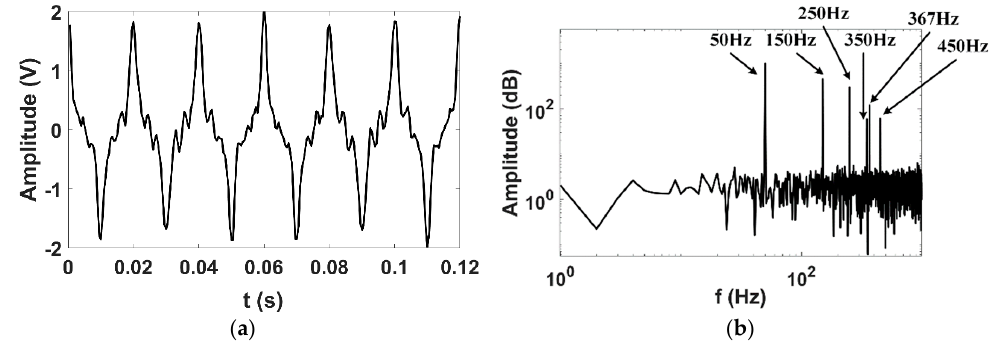
Figure 2. The magnitude and frequency spectrum of the grid voltage, ( a ) magnitude, and ( b ) frequency spectrum. and ( b ) frequency